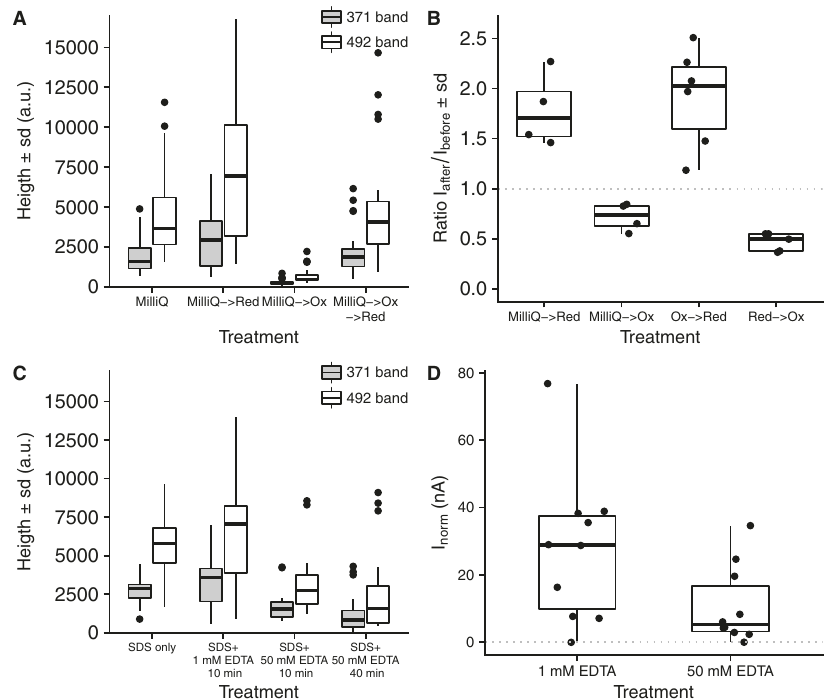
Fig. 4 Redox and Ni-removal experiments suggest that the Ni/S group plays a role in electron conduction. A The effect of oxidation and reduction on green laser Raman signals from the sulfur-ligated Ni group. The MilliQ → Red treatment ( N = 30) was signi fi cantly higher than the MilliQ treatment ( N = 28, p = 0.03) and the MilliQ → Ox treatment ( N = 23) was signi fi cantly lower than all other treatments ( p < 4 × 10 − 9 ). The MilliQ → Ox → Red treatment ( N = 33) was not signi fi cantly different from the MilliQ ( p = 0.7) and the MilliQ → Red ( p = 0.07) treatments The ratio between the 371 and 492cm − 1 Raman bands was not affected by oxidation or reduction. B The effect of oxidation and reduction treatments on the conductance of individual fi ber sheaths. The ratio of the electrical current (I) through the fi ber sheath is plotted before and after treatment. The effect in all treatment pairs was signi fi cant (MilliQ → Red p = 0.01 ( N = 4); MilliQ → Ox p = 0.01 ( N = 4); Ox → Red p = 0.001 ( N = 6); Red → Ox p = 0.004 ( N = 5), all tested against no effect Ratio = 1). C The effect of EDTA with on green laser Raman signals from the sulfur-ligated Ni group. The decrease in Raman signal between the standard protocol ( N = 13) and both high EDTA treatments was signi fi cant (10 min. 50 mM EDTA p = 0.04 ( N = 15); 40 min. 50 mM EDTA p = 0.03 ( N = 22)). The SDS only treatment ( N = 15) was not different from the standard protocol ( p = 0.7). D The effect of high EDTA extraction on normalized conduction of individual fi ber sheaths (I norm : electrical current normalized to fi lament length 0.3 mm and bias 0.1 V). Fibers sheaths were extracted with the standard protocol (1% SDS + 1 mM EDTA 10 min) and high EDTA treatment (1% SDS + 50 mM EDTA 10 min). The decrease in I norm between the standard protocol